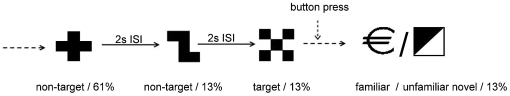
Modified oddball task.Altogether 460 target, non-target and novel (non-target) symbols were presented to each subject in the current modified oddball task. Meaning-wise, novels were either familiar (relative novel) or non-familiar (complete novel). The symbols appeared at intervals of 2 seconds in randomised order.